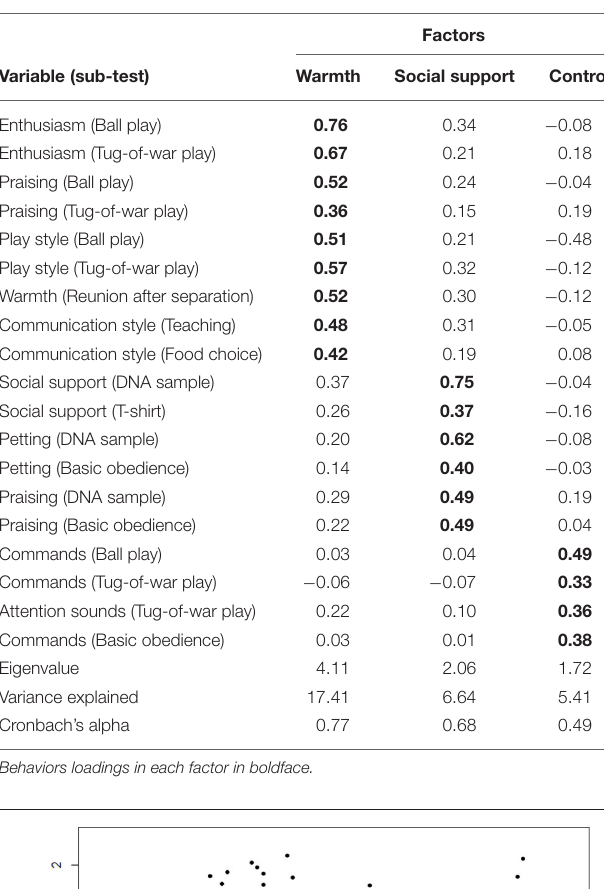
TABLE 3 | Rotated factor matrix restricted to three factors.